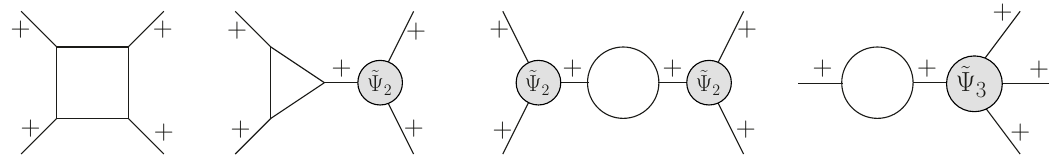
Figure 9 . The first three diagrams from the left represent types of contributions to the (++++) one-loop amplitude obtained from eq. (3.22). Inclusion of the last diagram (with external bubble) makes the sum of all diagrams zero, what is useful to evaluate amplitude — see the main text. Notice, that there is no propagator between the Ψ kernels and the rest of the diagram — it is n included inside the kernel, which resums the tree-level